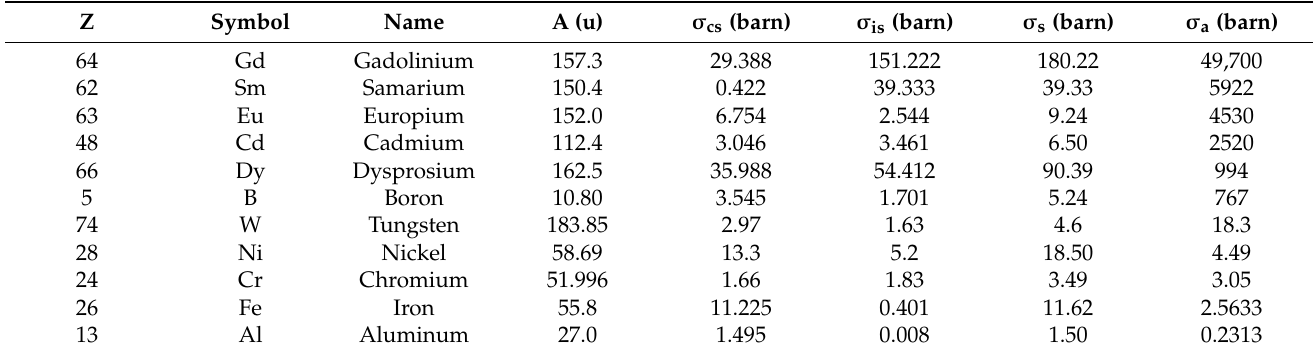
Table 1. Cross section values of a common neutron absorber in the spent fuel field